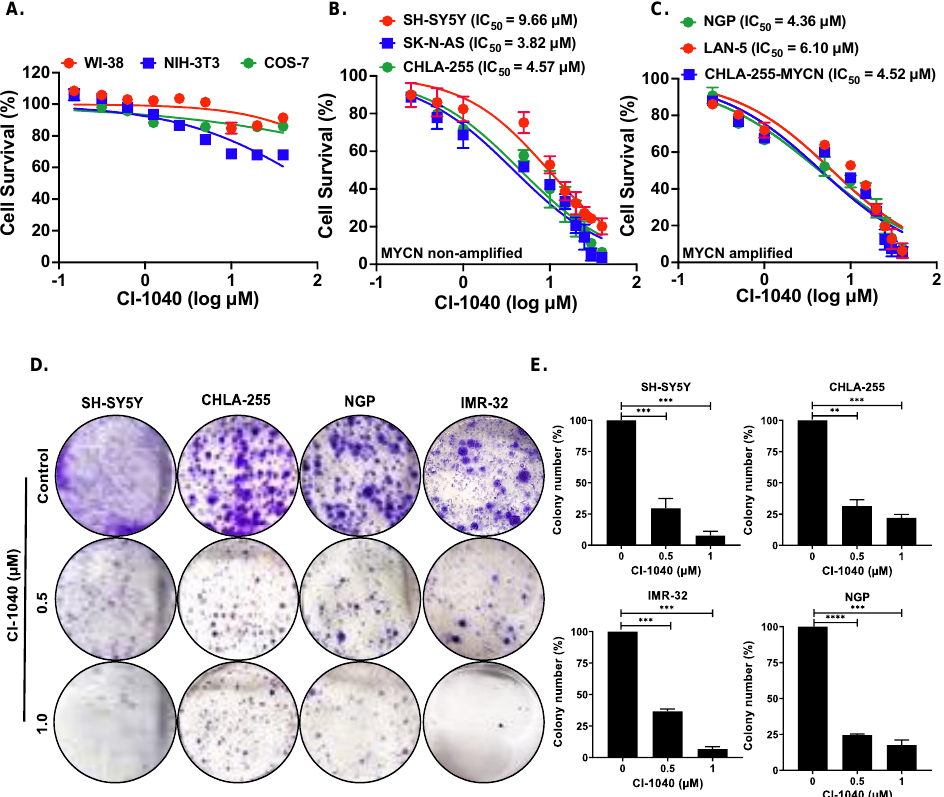
Figure 3. CI-1040 inhibits NB cell proliferation. ( A – C ) Cytotoxicity assays were performed in six NB cell lines including 3 MYCN-amplified and 3 MYCN non-amplifies, and 3 non-cancerous fibroblast cell lines, in response to CI-1040. ( A ) Non-cancerous fibroblast cell lines (WI-38, NIH-3T3, COS-7). ( B ) MYCN non-amplified cell lines (SH-SY5Y, SK-N-AS, CHLA-255). ( C ) MYCN amplified cell lines (NGP, LAN-5, CHLA-255-MYCN). IC 50 values were calculated and shown in parentheses. ( D , E ) Colony formation assays were performed in 4 NB cell lines including MYCN-amplified (LAN-5, IMR-32) and MYCN non-amplified (SH-SY5Y, CHLA-255) in response to CI-1040. ( D ) Representative images of colony formation assay in response to CI-1040 treatment in NB cell lines. ( E ) Quantitation of the colony numbers in response to CI-1040 treatment. ** p < 0.01, *** p < 0.001, and **** p <